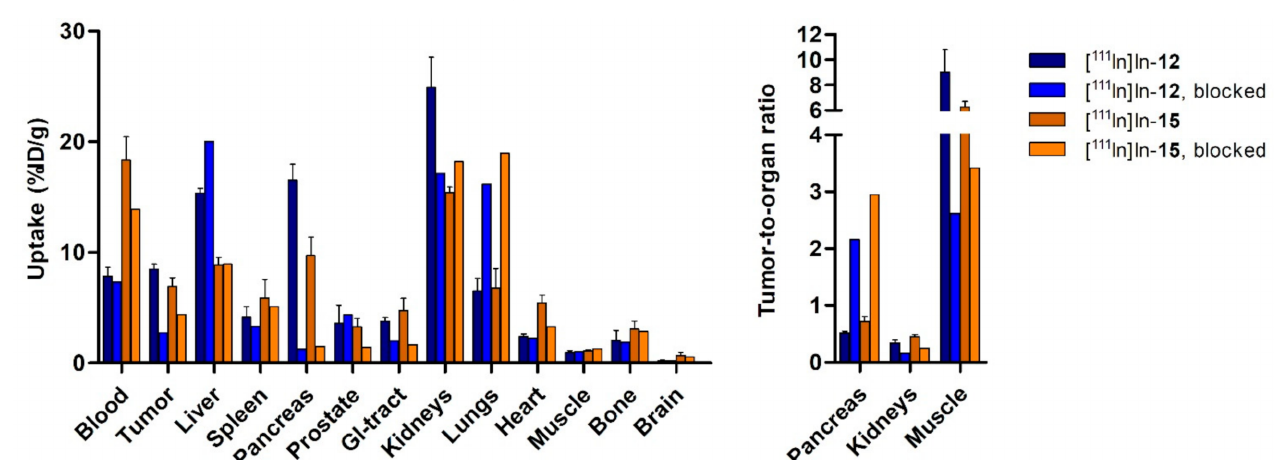
Figure 3. Ex vivo biodistribution (left) and tumor-to-organ ratios (right) of [ 111 In]In- 12 and [ 111 In]In- 15 in PC-3-xenograft Balb/c nu/nu mice after SPECT/CT scanning. Mice were injected intravenously with 1 nmol of [ 111 In]In- 12 or [ 111 In]In- 15, alone or in combination with 150 nmol of non-labeled NeoB (blocked). Radioactivity uptake in tissues was calculated as a percentage of the injected dose per gram of tissue (%ID/g). Data for the unblocked group are presented as an average value ± SD ( n =